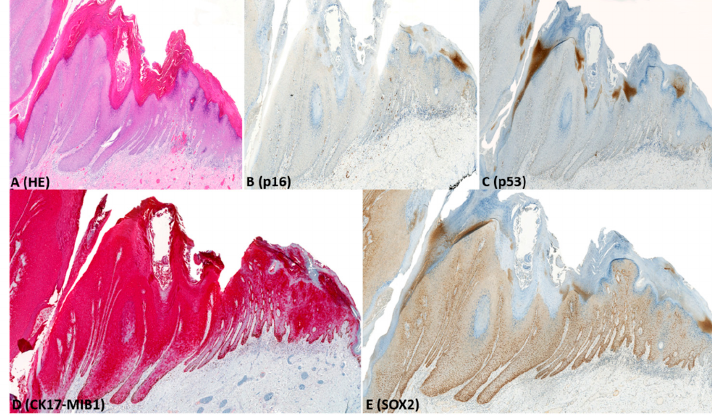
Figure 3. Example of immunohistochemical expression of p16, p53, CK17-MIB1, and SOX2 in differentiated exophytic vulvar intra-epithelial lesion (de-VIL); ( A ) Histological appearance of de-VIL (HE-stain); ( B ) complete lack of p16-expression; ( C ) wild-type (scattered) p53-expression; ( D ) diffuse, strong CK17-expression across full epithelial thickness and increased MIB1-expression; ( E ) diffuse, strong SOX2-expression across full epithelial thickness.